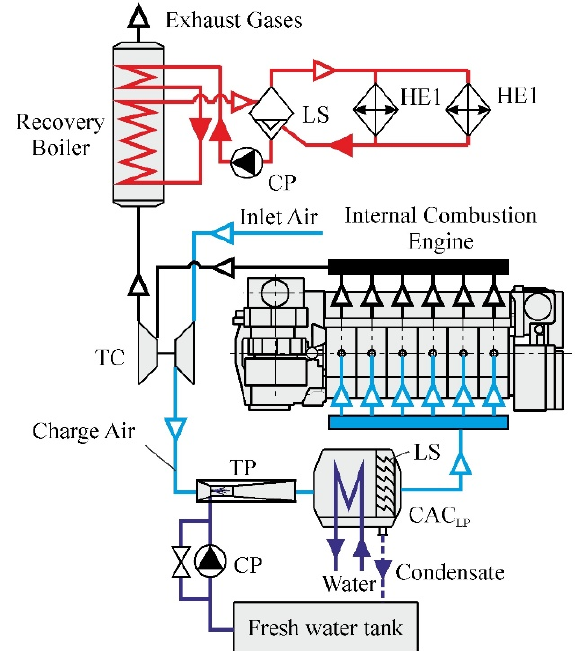
Figure 11. A scheme of the charge-air-cooling system with a thermopressor for low-speed marine